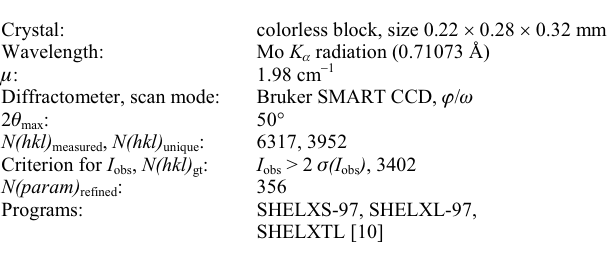
Table 1. Data collection and handling.